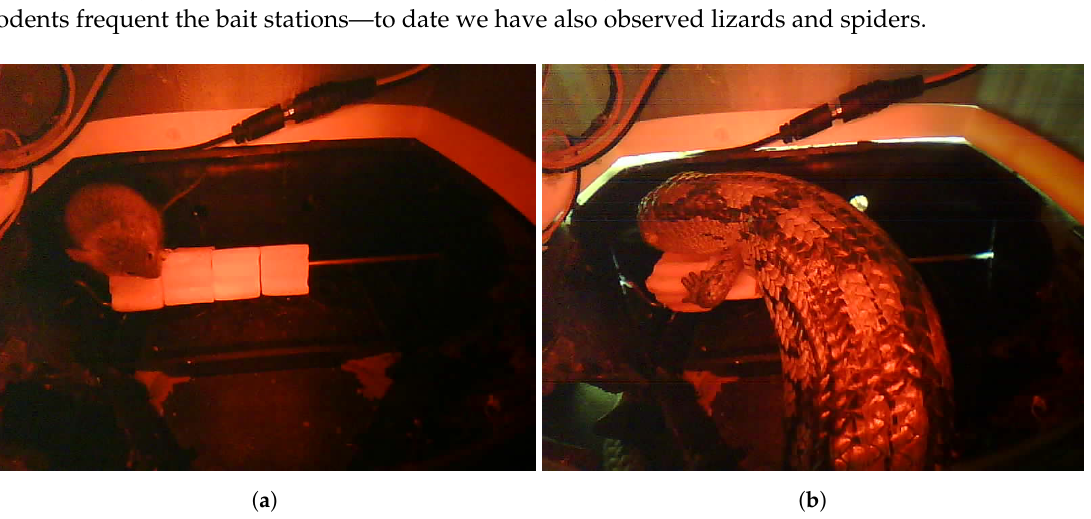
Figure 8. Motion triggered captures showing a rat ( a ) and a blue-tounge lizard ( b ) from a farm in rural